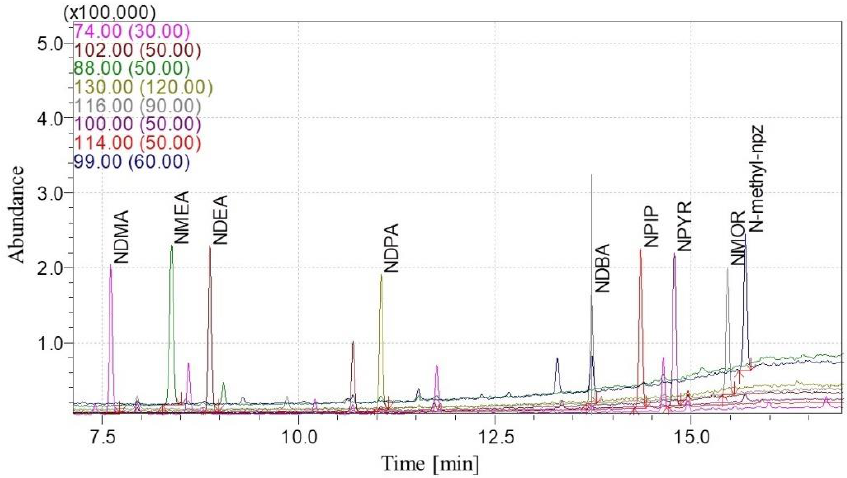
Figure 3. SIM mode chromatogram of the N-nitrosamines standard—18 ng/mL. Table 1. Validation results for linearity, LOD, and LOQ.